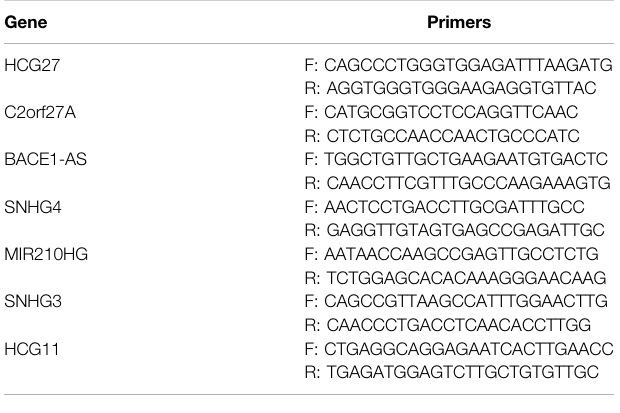
TABLE 1 | PCR primer